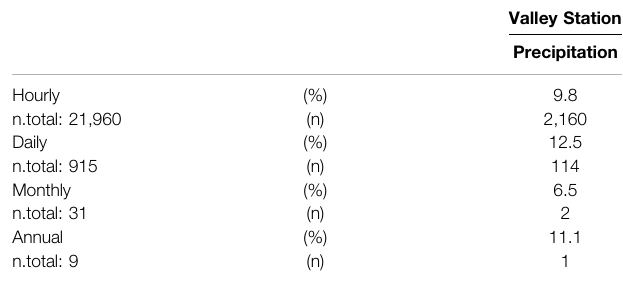
TABLE 2 | Percentage and total number (n.total) of missing values of the Valley Station for hourly, daily, monthly and annual/rainy season precipitation